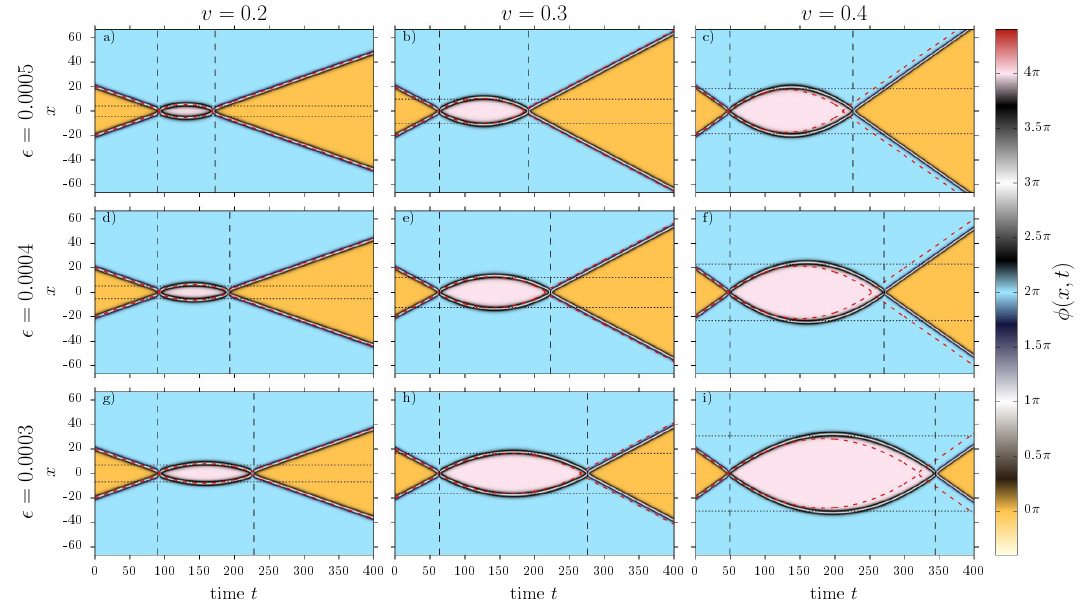
Figure 8 . Collisions between an antikink and a kink with excitation of the false vacuum in the deformed model (2.1). The plots represent the field values as functions of the impact velocity and the time. Black dashed lines show the theoretically predicted bubble size and life-time. Red dashed lines show the paths calculated from the effective model (4.7). Note that the effective model is non-relativistic, and this is reflected in the worsening of its predictions with increasing velocities. with them enable a smooth transition from the situation for (cid:15) > 0 back to sine-Gordon scattering at (cid:15) = 0